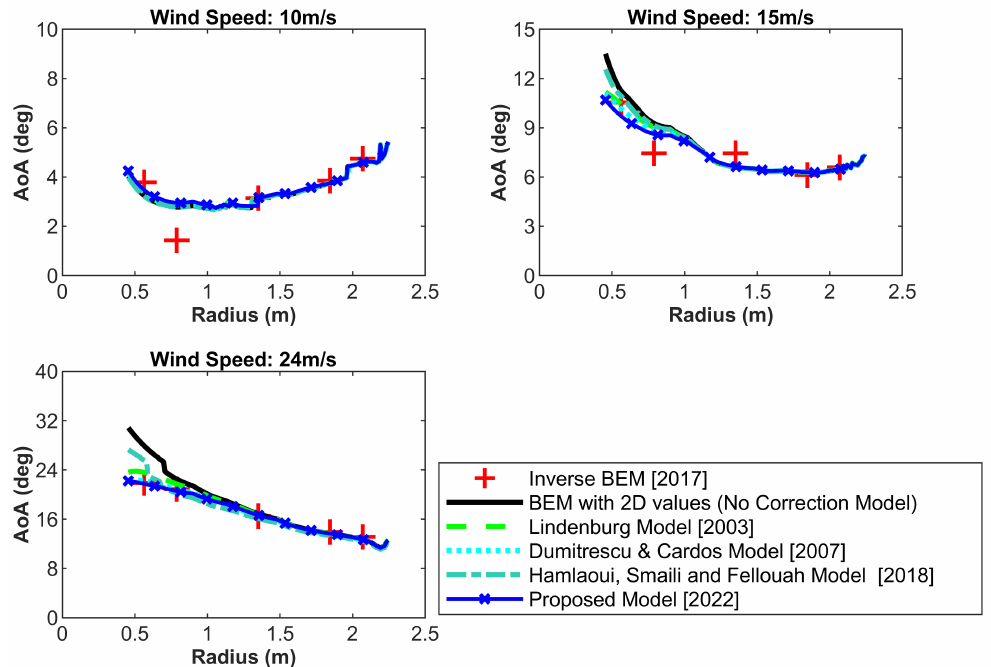
Figure 7. Contrast of evaluated AoAs throughout the blade length from BEM analysis without and with different correction models for stall delay and Inverse BEM method for MEXICO